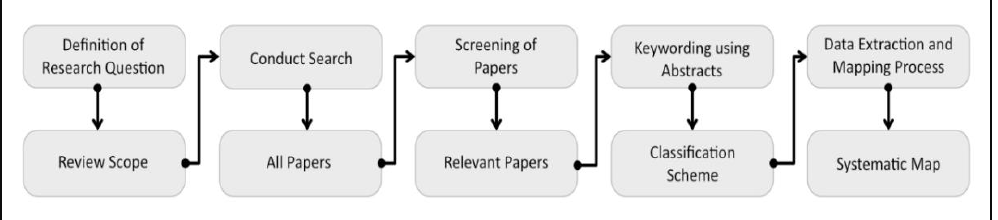
Figure 2. Systematic mapping methodology.